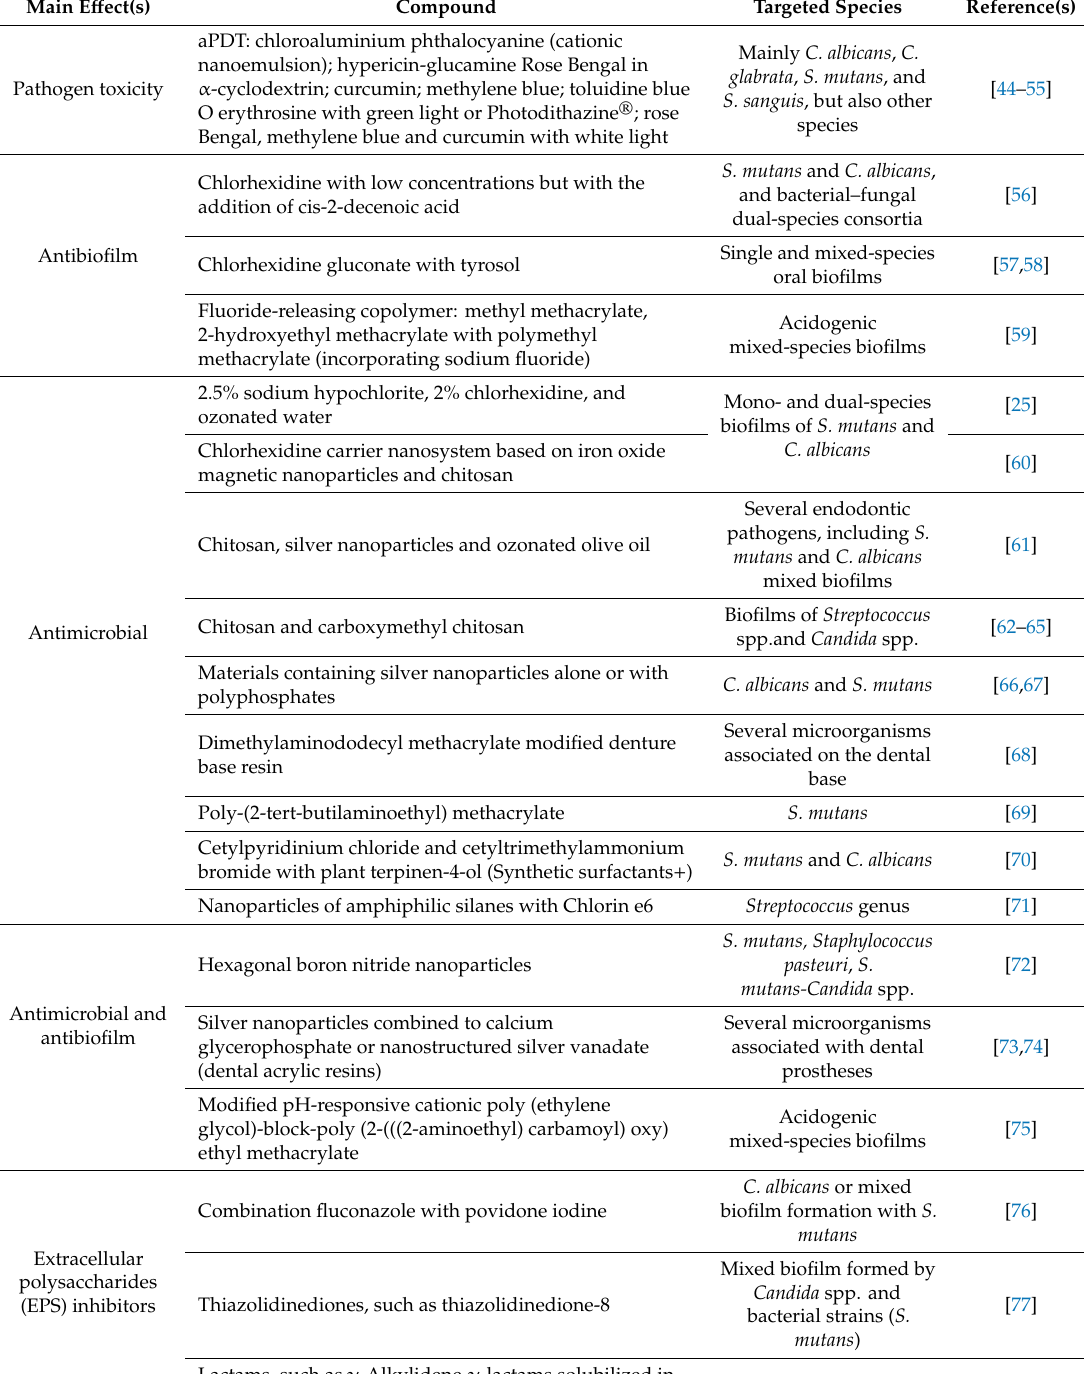
Table 1. Chemical compounds and their bioactivity against Streptococcus spp. and Candida